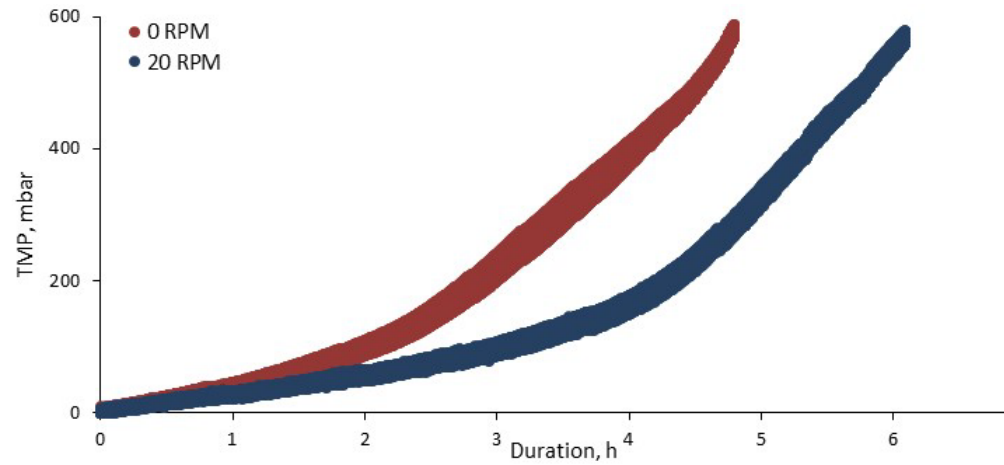
Figure 3. Example of impact of reciprocation on the pressure transient.